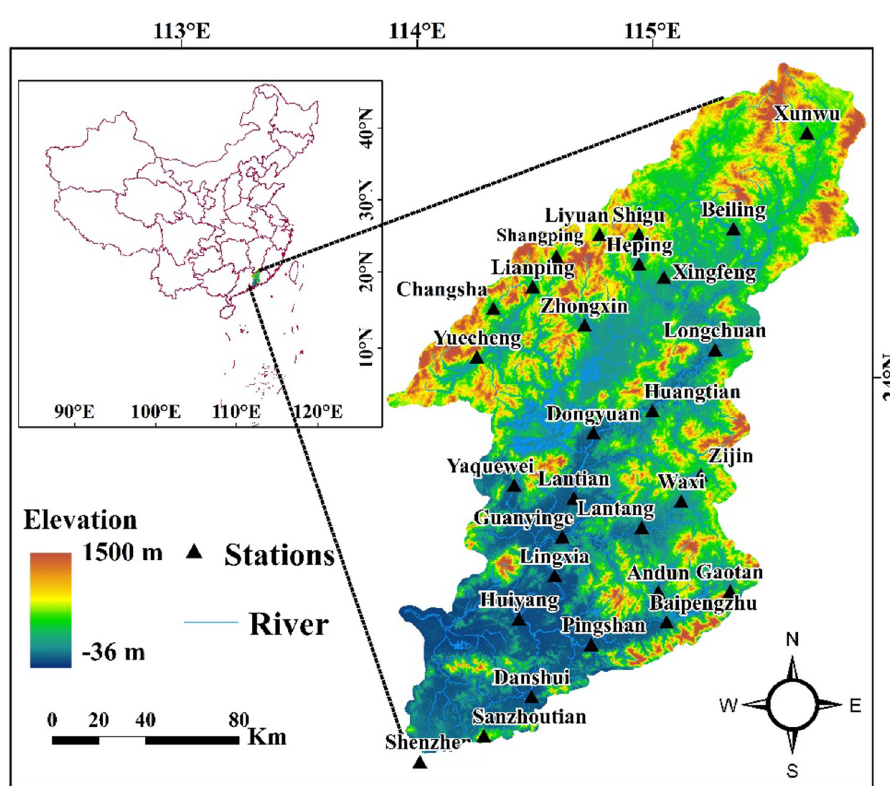
Fig. 1 Location of the study region—the East River basin— and the 29 precipitation stations used in the